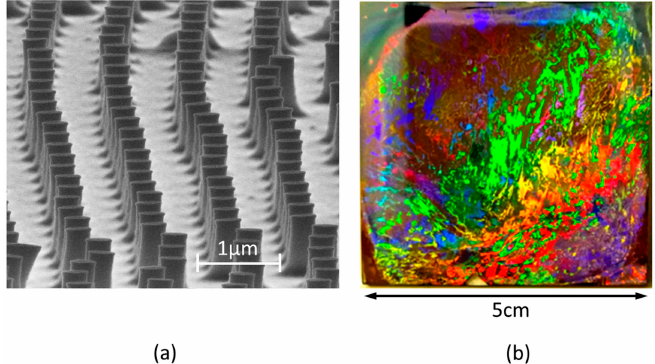
Figure 5. Global view of the hexagonally arranged nanostructures with high aspect ratio: ( a ) SEM of the array of nanopillars; ( b ) macroscopic view of the structure under white light illumination, showing the typical rainbow effect of periodic surface structures.